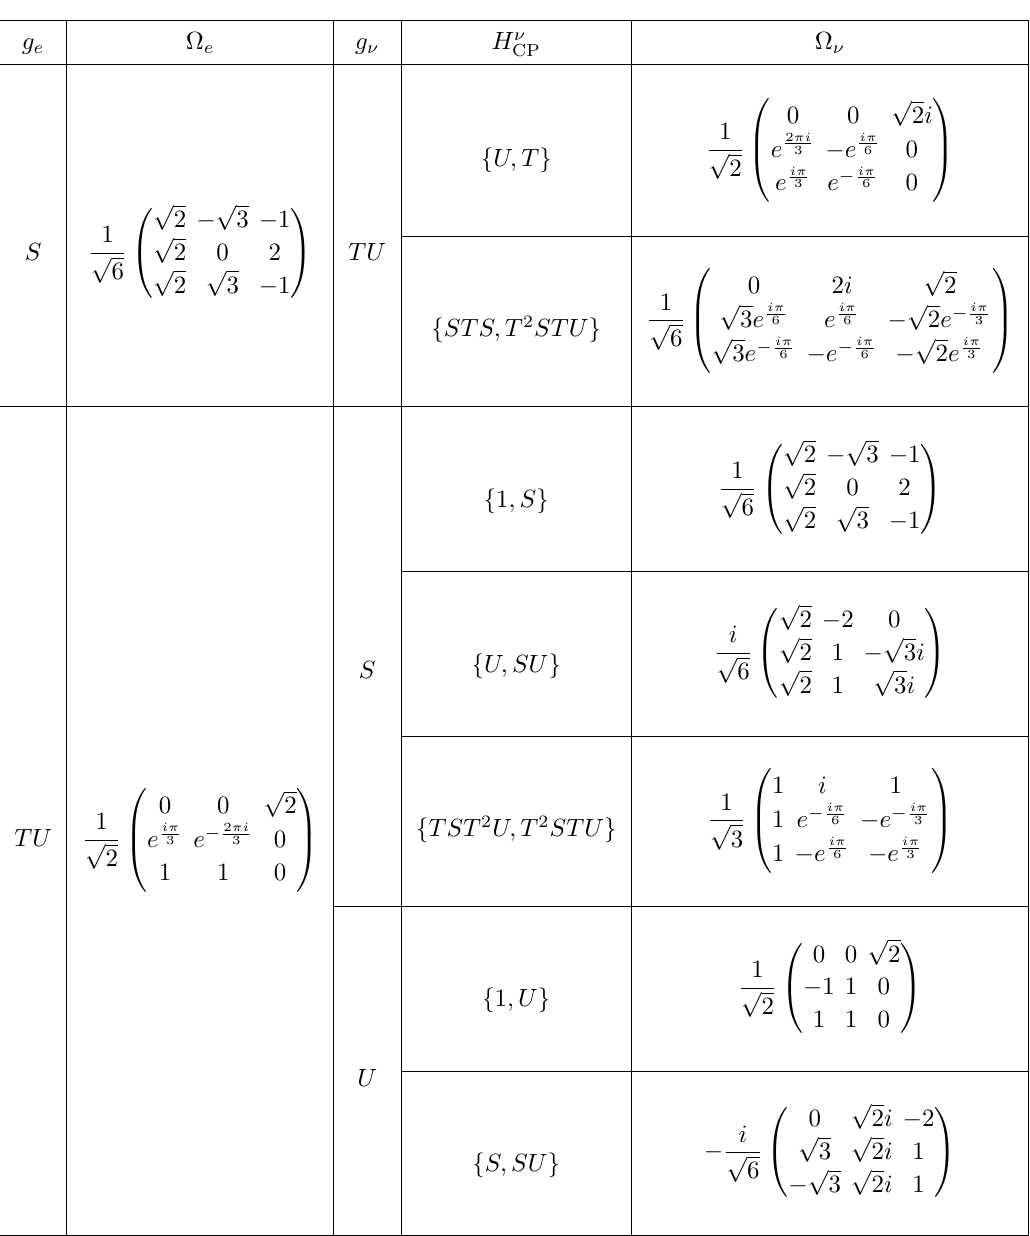
and G (cid:23) = Z g (cid:23) (cid:2) H (cid:23) 2 2 CP = f X (cid:23) 1 ; X (cid:23) 2 g of CP